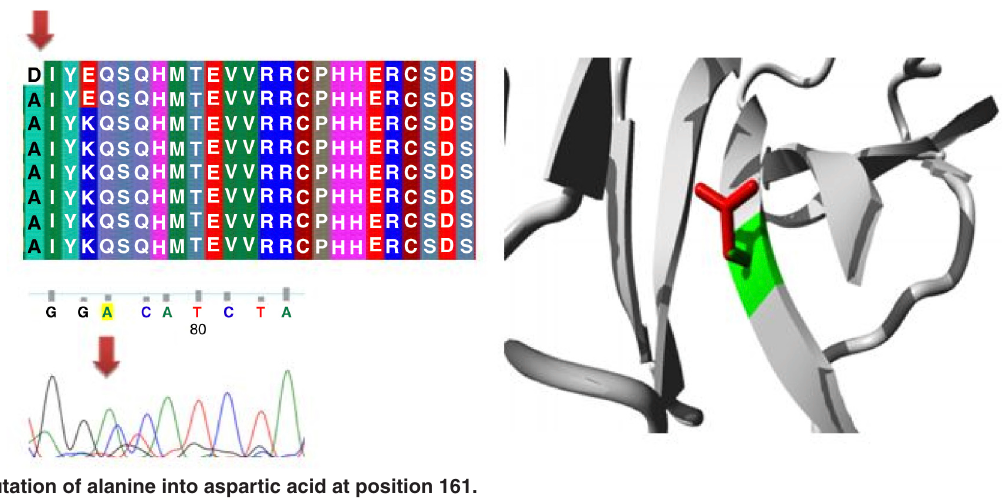
Figure 3. Mutation of alanine into aspartic acid at position 161.